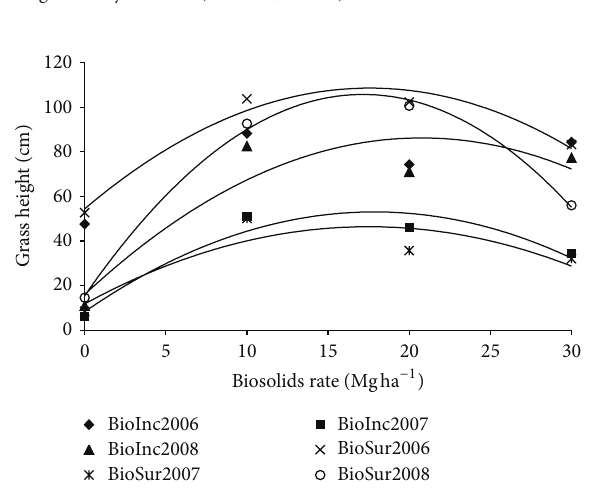
Figure 3: Grass height under different biosolids rates, methods of application (BioInc: soil-incorporated method; BioSur: surface- applied method), and dates (year 2006, 2007, or 2008) at a seeded abandoned field in Chihuahua, Mexico. 𝑌 0.1320 ) or quadratic effect ( 𝑃 = 0.2348 ), 𝑛 = 8 ; 𝑌 8.33 + 5.00𝑥 − 0.14𝑥 2 , 𝑃 = 0.0001 , 𝑟 2 = 0.92 , 𝑛 = 8 ; 𝑌 16.04 + 6.76𝑥 − 0.163𝑥 2 , 𝑃 = 0.0139 , 𝑟 2 = 0.84 , 𝑛 = 8 . 𝑌 54.43 + 6.15𝑥 − 0.17𝑥 2 , 𝑃 = 0.96 , 𝑟 2 = 0.96 , 𝑛 = 8 ; 𝑌 11.84 + 3.95𝑥 − 0.11𝑥 2 , 𝑃 = 0.0003 , 𝑟 2 = 0.75 , 𝑛 = 8 ; 𝑌 15.47 + 10.51𝑥 − 0.30𝑥 2 , 𝑃 = 0.0001 , 𝑟 2 = 0.93 , 𝑛 = 8